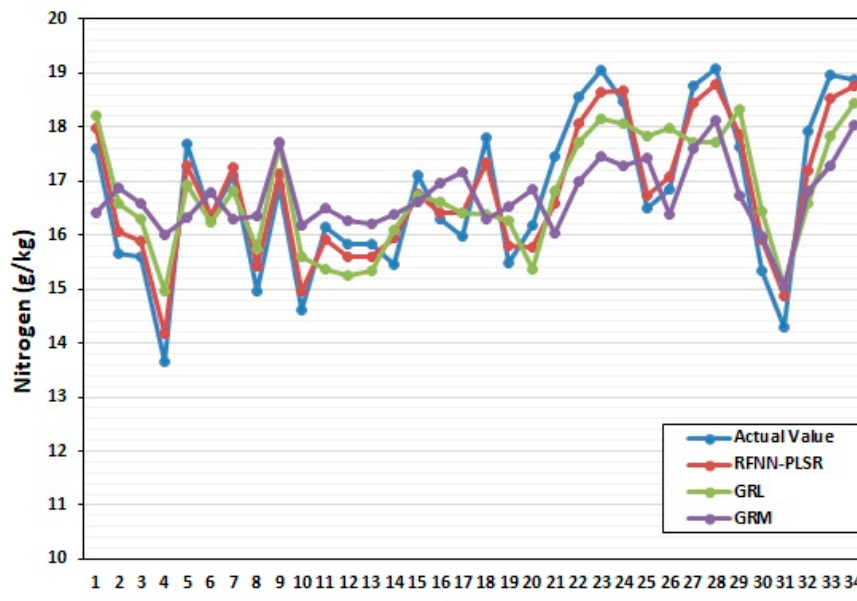
Figure 5. Training model during rice growing stage.